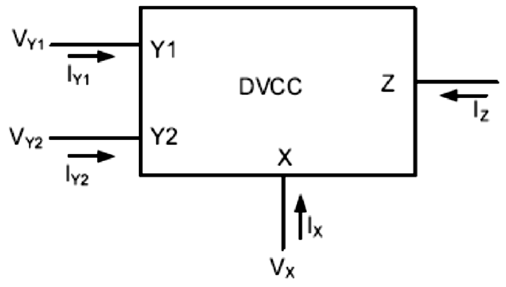
Figure 1. Differential voltage CCII block diagram.